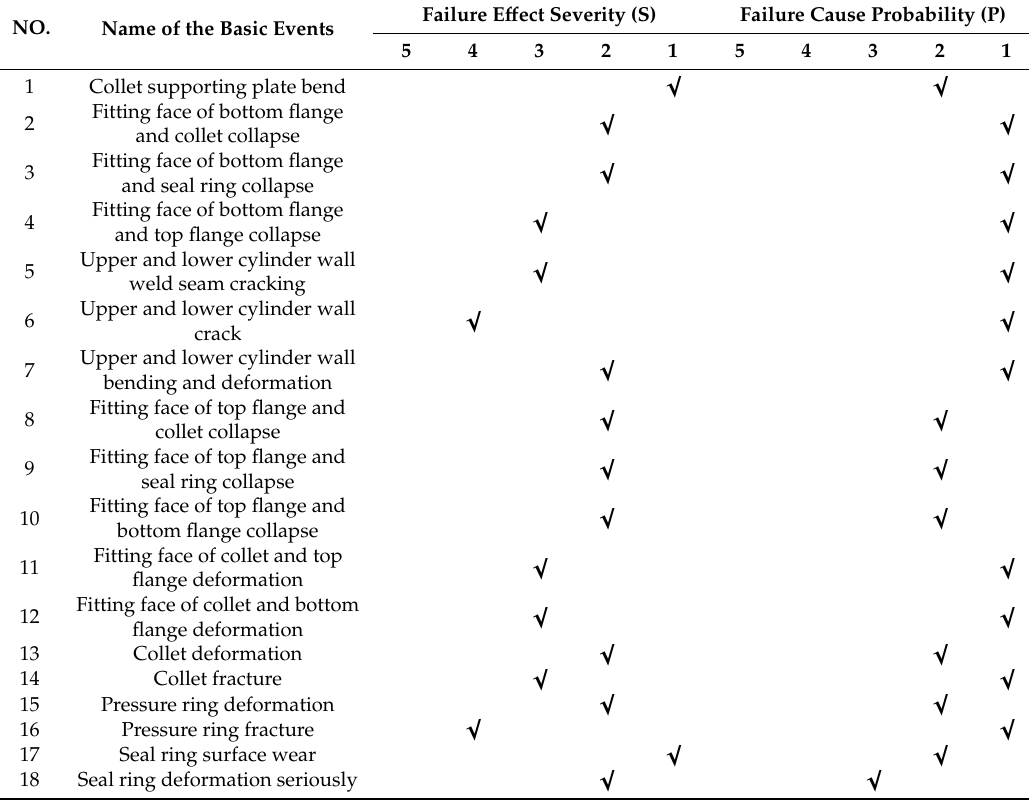
Table 4. Subsea collet connectors’ failure modes (fault tree basic events)